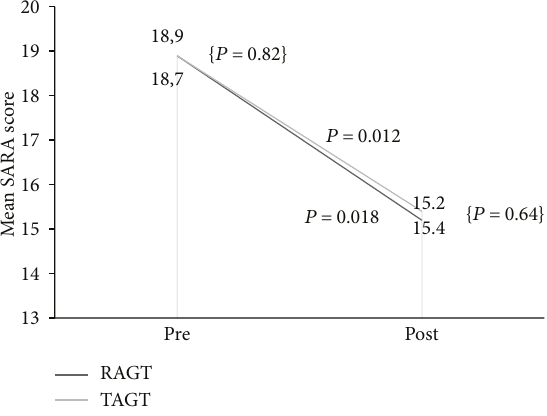
Figure 1: Changes in assessment and rating of ataxia. P value represents intragroup di ff erences. Requirement for a statistically signi fi cant di ff erence: P < 0 05 . P value for between-group comparison: { P = 0 82 ; P = 0 64 } . Requirement for a statistically signi fi cant di ff erence: P < 0 05 .